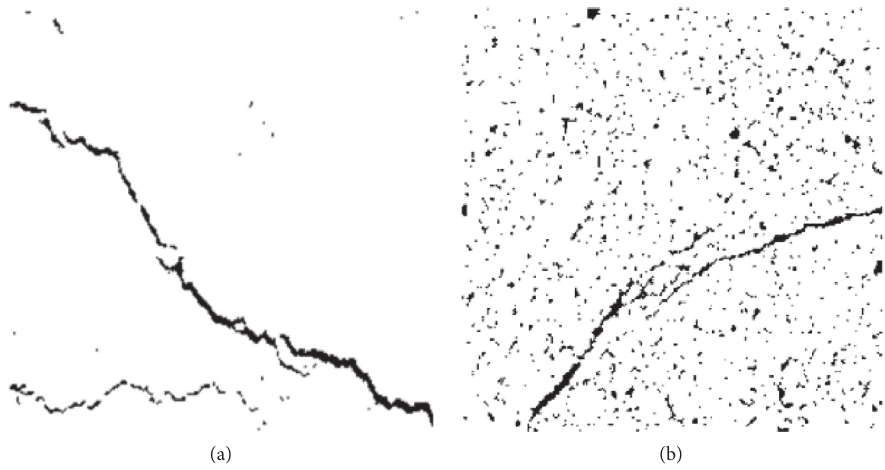
Figure 24: Percolation results using the zero-padding technique: (a) crack 1; (b) crack